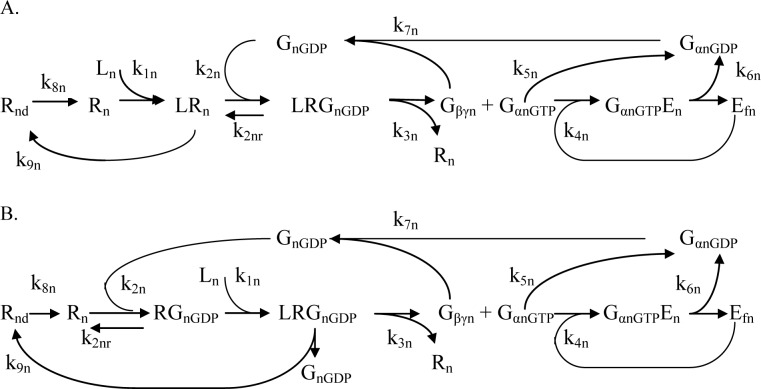
Diagram of the kinetic model of ligand, G protein and target enzyme interactions.Rnd is the desensitized receptor, Rn is the free receptor, Ln is the ligand, LRn is the receptor bound with ligand, LRGnGDP is the receptor bound with ligand and G protein, GnGDP is the G proteins consisting of subunits α, β and γ. In this ground state the α-subunit is bound to GDP. GαnGTP is the GTP-bound α subunit of G protein, Gβγn is the β and γ subunit of G protein, GαnGDP is GDP-bound α subunit of G protein, GαnGTPEn is the complex of the α-subunit carries the GTP and effectors enzyme (En). Efn is the enzyme that is not bound with G protein. The constants can be identified by their subcripts, where n the forward transition and nr is the reverse transition. For reversible reactions (double arrows), forward reactions are in the direction of association. (A) Collision coupling model. (B). Pre-coupling of receptor and G-protein model.